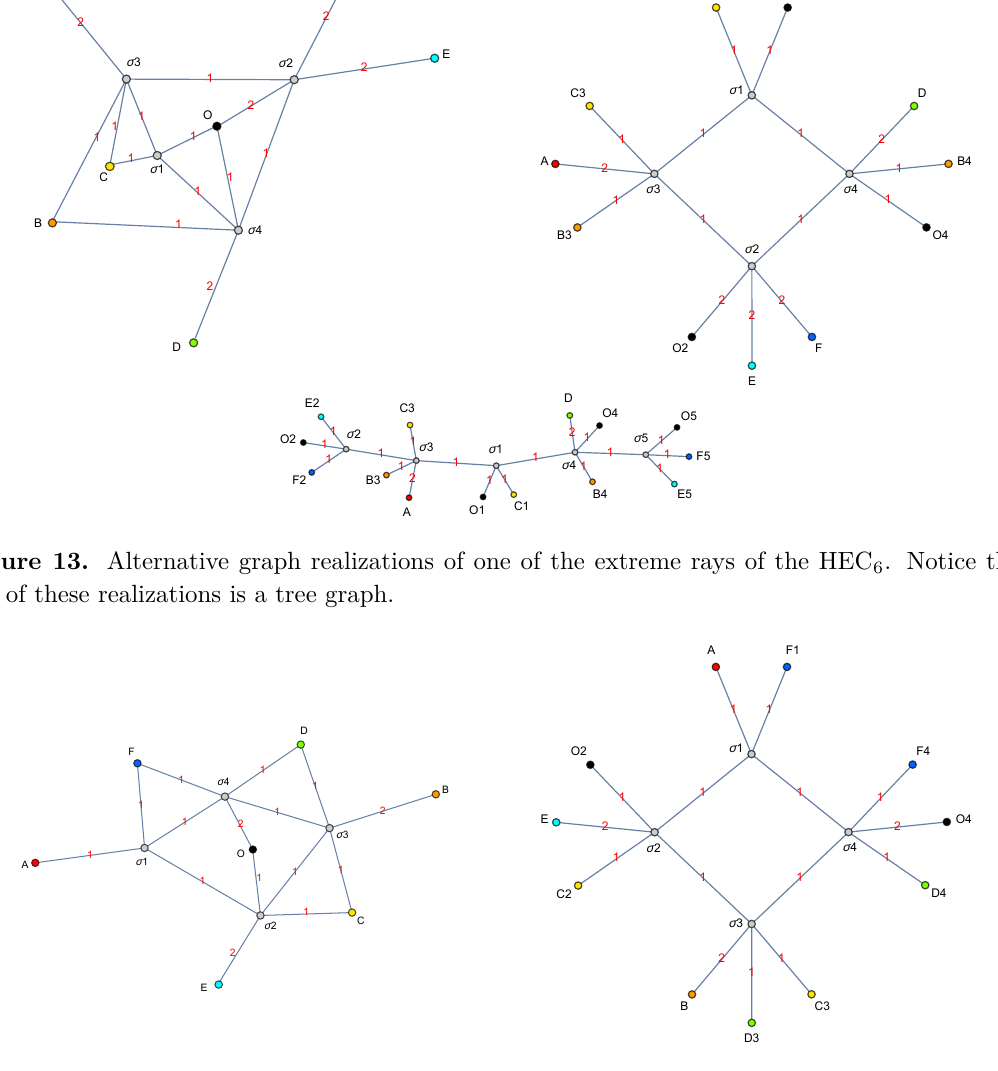
Figure 14. Alternative graph realizations of another extreme ray of the HEC 6 . Notice that the graph on the right has the same topology as the second graph in fig.